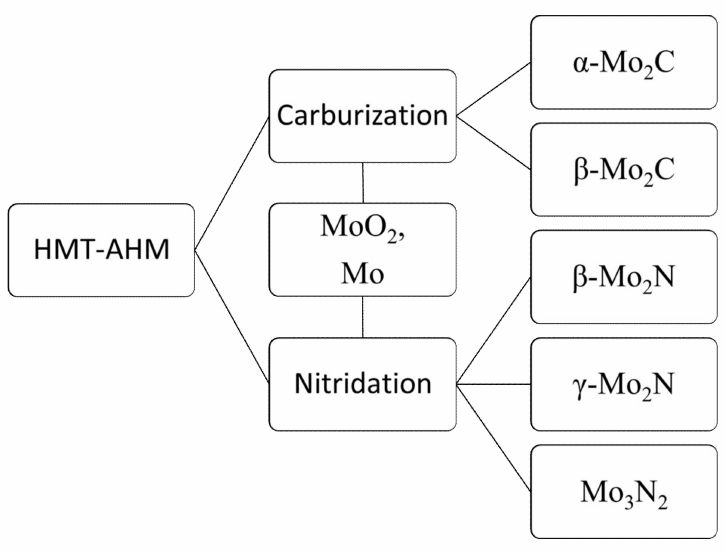
Figure 15. A general scheme of the carburization/nitridation process of HMT-AHM.